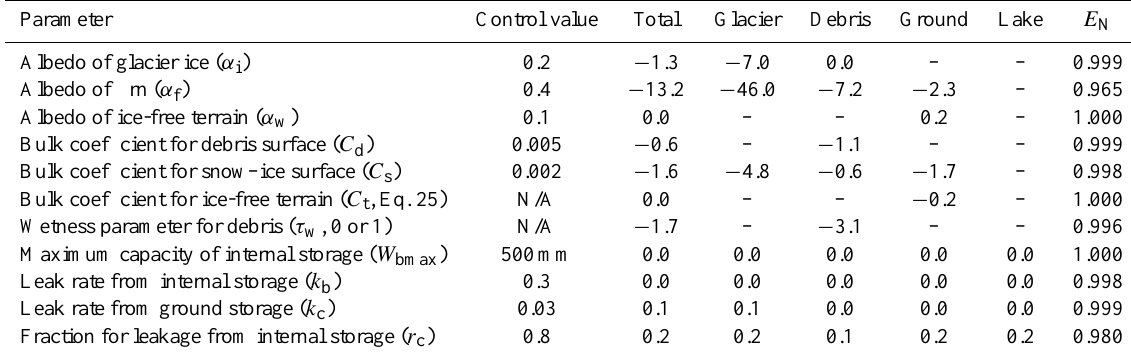
Table 4. Uncertainty in runoff due to parameters used in the model of the Tsho Rolpa Glacial Lake–Trambau Glacier basin. Influences are obtained by changing each parameter by ± 30%, averaged anomalies from positive and negative cases (Eq. 33), and then expressed as a percentage of the control values (Table 1). Nash–Sutcliffe model efficiency coefficient ( E N ) is obtained against the control